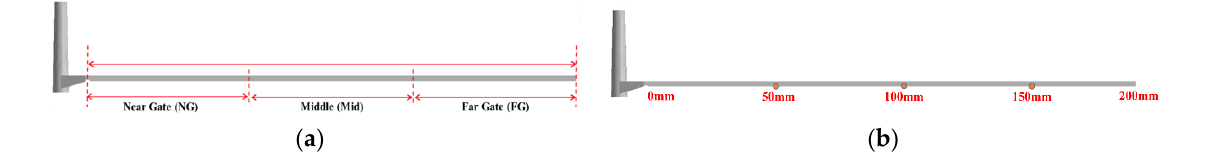
Figure 4. Measurement position for ( a ) shrinkage and ( b ) warpage.